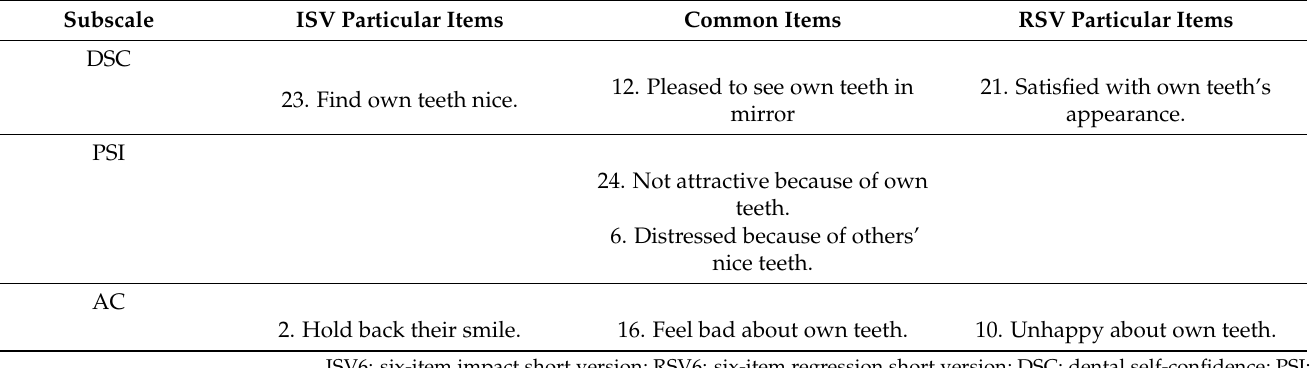
Table 4. Items of PIDAQ(A)-ISV6 and PIDAQ(A)-RSV6. Subscale